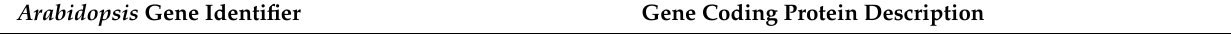
Table 9. Key non-radiation-induced genes interacting with ATR/ATM radiation induced genes. Arabidopsis Gene Identifier Gene Coding Protein Description